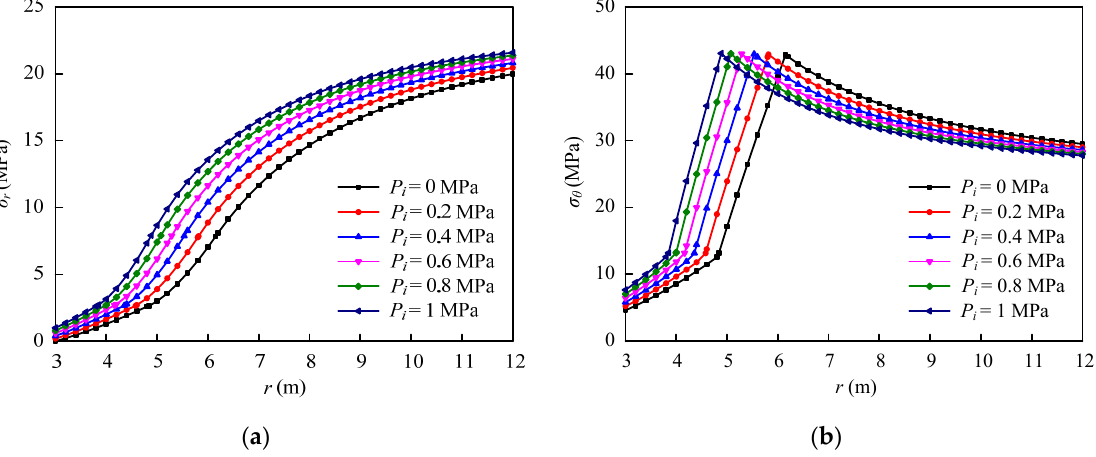
Figure 12. Effect of initial support resistance on the stress distribution in the tunnel surrounding rock. ( a ) σ r ; ( b ) σ θ .